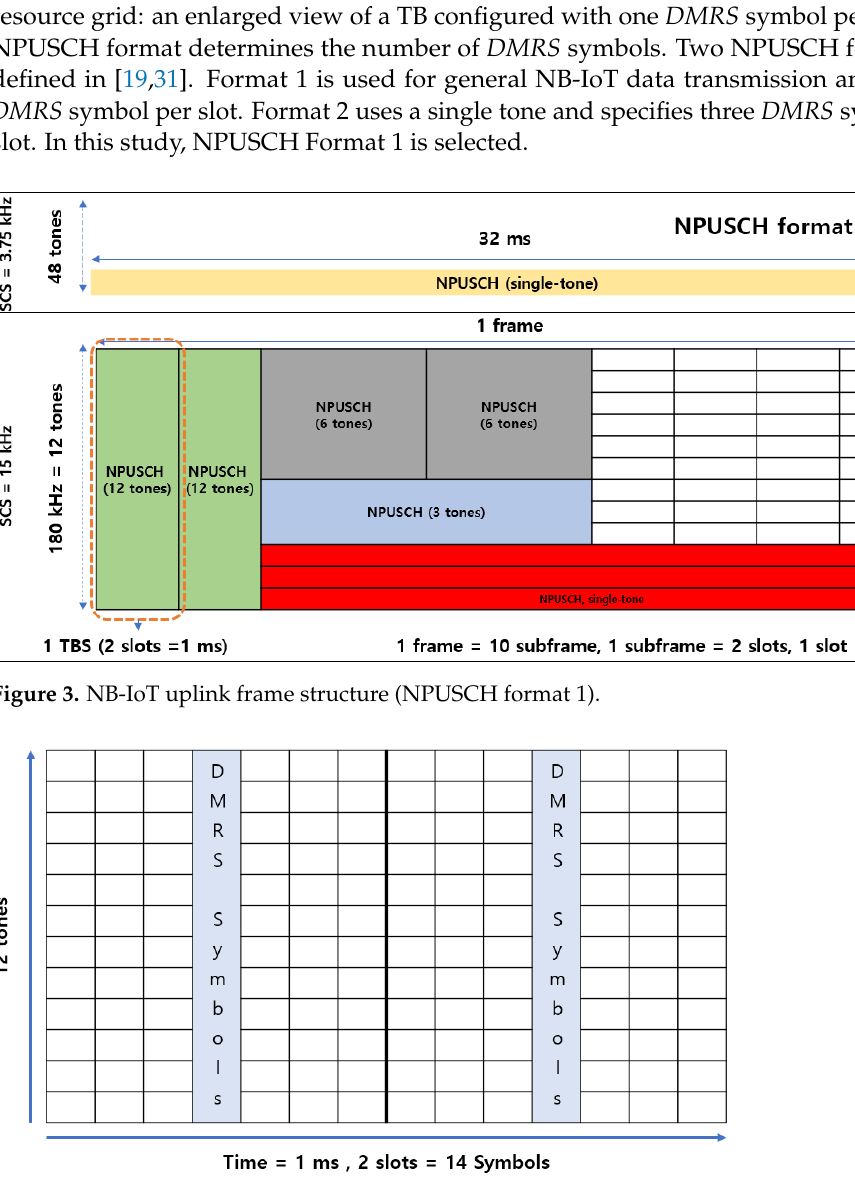
Figure 4. NB-IoT resource grid (1 slot = 0.5 ms, 1 tone = 15